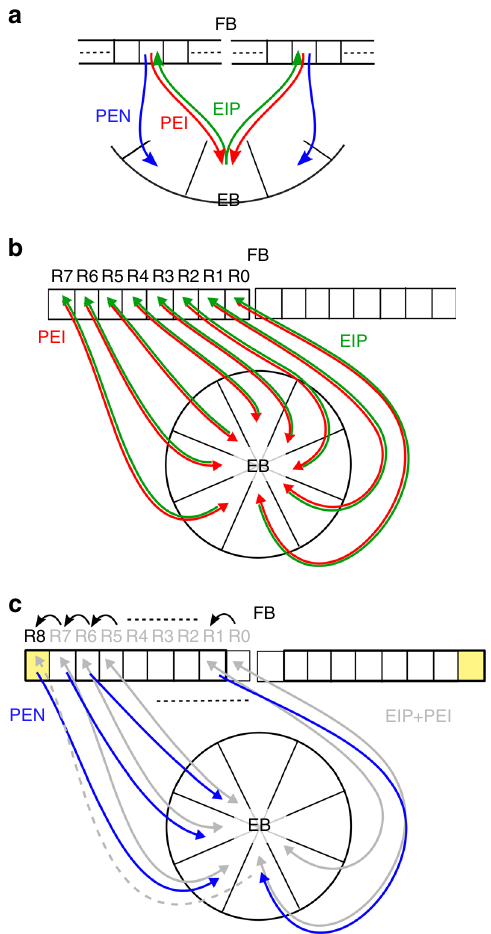
Fig. 8 Schematics of the shifter circuit in the EB – PB system. a In the EB – PB system, the PEN neurons form a shifter circuit by sending the signals from the PEI – EIP feedback circuit to the neighbor EB regions. We illustrate how the shifter circuit is formed in the b and c . b Consider the PEI neurons which innervates R0 – R7 regions. Each PEI neuron sends signals from one EB region to one PB dual region and the signals are sent back to the same PB region by an EIP neuron. Note that an EIP neuron actually innervates three EB regions, but two of them belong to the same dual region. For the simplicity, we only depict the innervation of the dual region for each EIP neuron. c To build a shifter circuit for the PEN neurons, we fi rst copy the innervation patterns of the PEI neurons and then shift the innervation sites in PB rightward by one region but leave the innervation sites in EB unchanged. To accommodate the change, we need to add a new PB region, R8, to the right side of PB. A new EIP neuron ( gray dashed line ) that innervates R8 has also to be added in order to complete the shifter circuit. Note that here we only depict the neurons innervating the right side of PB. The neurons innervating the left side of PB are simply the mirror images of the neurons in the right EIP, PEI, and PEN neurons are cholinergic. But it does not affect the core computational principle we demonstrate here because cholinergic synapses are excitatory, and computationally they function similarly to glutamatergic synapses with AMPA or NMDA receptors. Based on a previous immunocytochemistry study 35 , we modeled the ring neurons as GABAergic neurons. We de fi ned a “ dual region ” in the EB as a combination of two consecutive regions of the EB. For example, the dual region L23 represents the combination of regions of L2 and L3. This reduced the 16 regions of the EB to only eight dual regions and greatly simpli fi ed the network analysis and graphical representation. Such reduction is also anatomically meaningful because each PEN or PEI neuron innervates one such dual region in the EB (Figs. 2a, b).